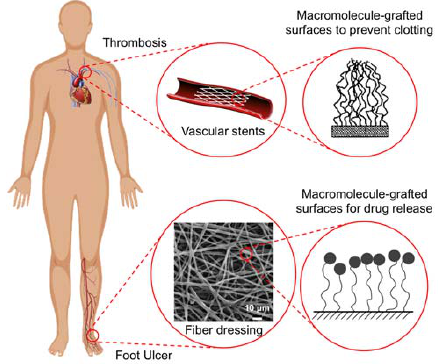
Figure 1. Surface functionalization of injectable and implantable biomaterials with macromolecules illustrated in biomedical applications of thrombosis and non-healing wounds. The attachment of the surface features on medical devices creates nanostructure-enabled and macromolecule-grafted surfaces that prevent blood clotting in thrombosis, as well as promoting the controlled drug delivery from nanofibrous dressing for non-healing